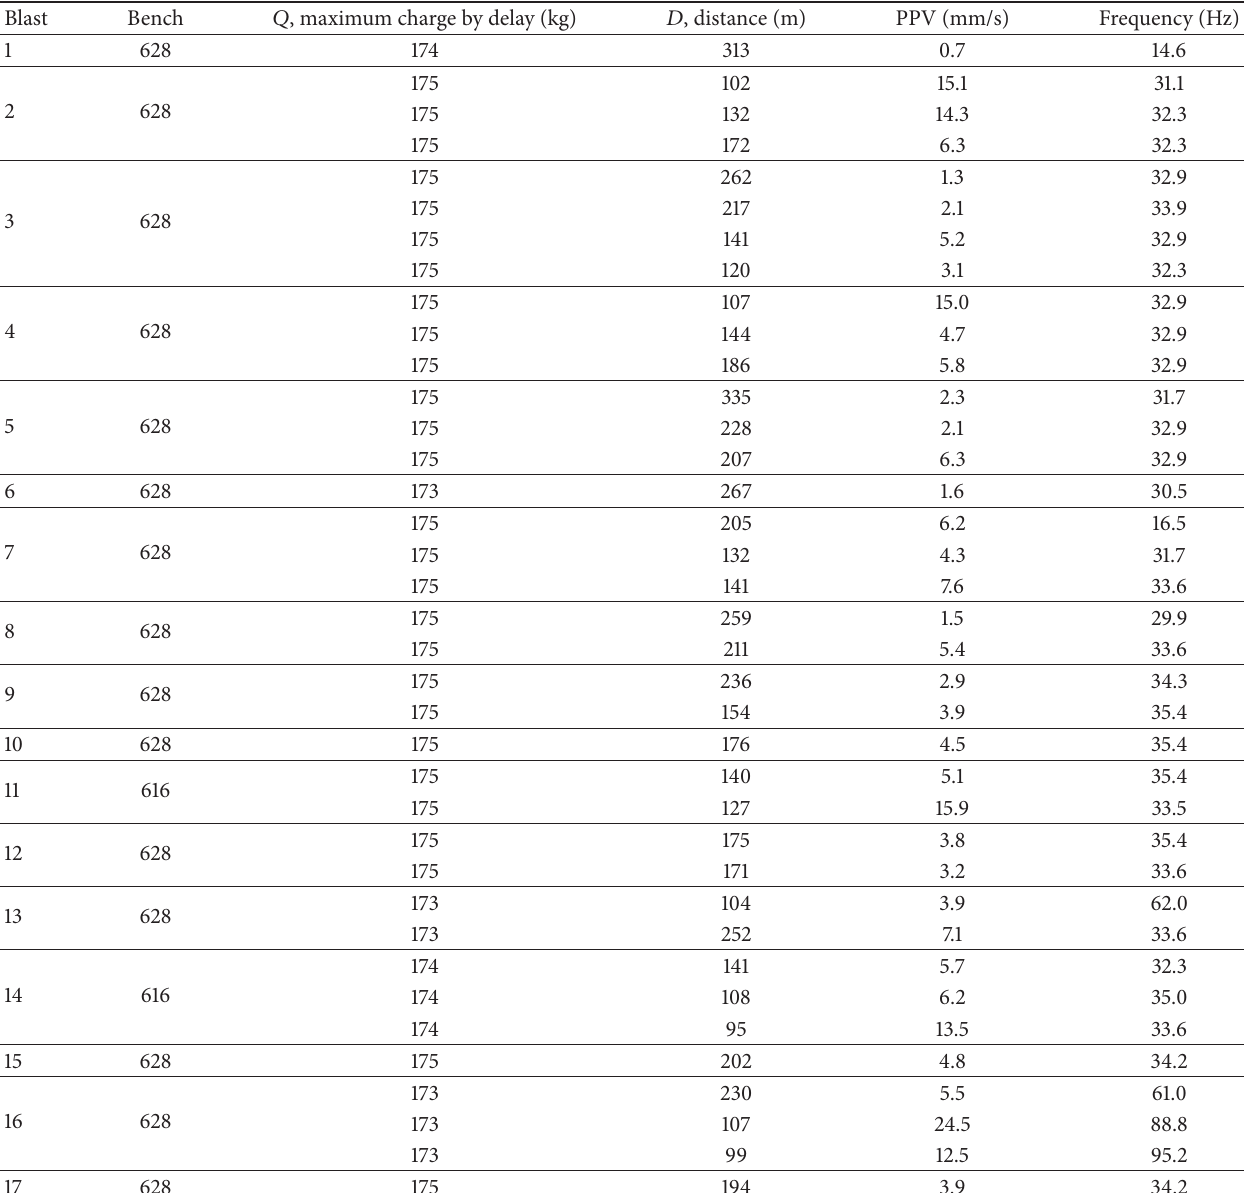
Table 2: Vibration measurements taken in